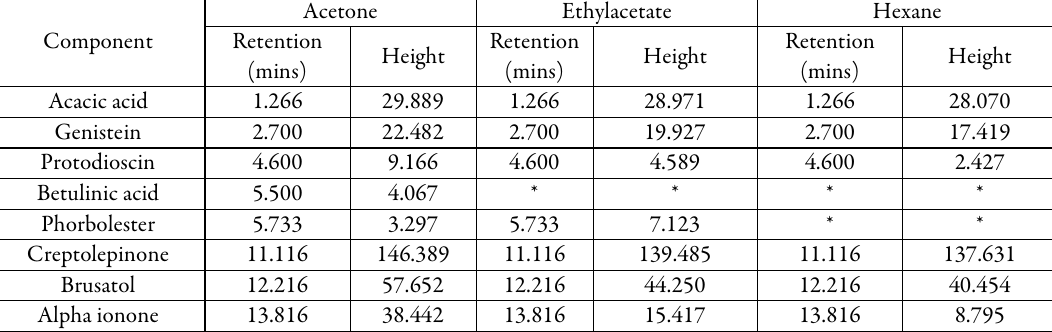
Table 3. Constituents of different solvent extracts of Carica papaya separated by HPLC